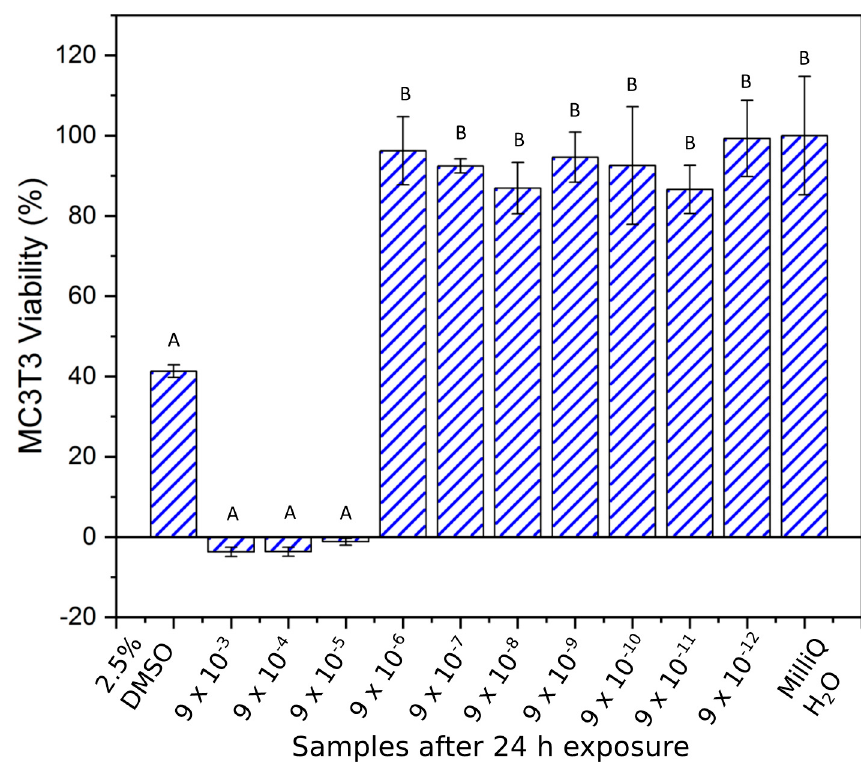
Figure 6. MC3T3 cell viability (mean ± SD) investigation after 24 h of Cu ion exposure. Brown–Forsythe: F (1, 10) = 3.22, p = 0.004. Nonparametric Kruskal–Wallis test showed significant differences among groups (H = 36.53, df = 11, p < 0.001). Note: Samples indicated with the same letter are non-significantly different, e.g., “A” denotes that samples indicated with “A” are non-significantly different ( p > 0.05). This also applies to samples indicated with “B”. Conversely, samples indicated with differing letters denote statistically significantly different ( p < 0.05).